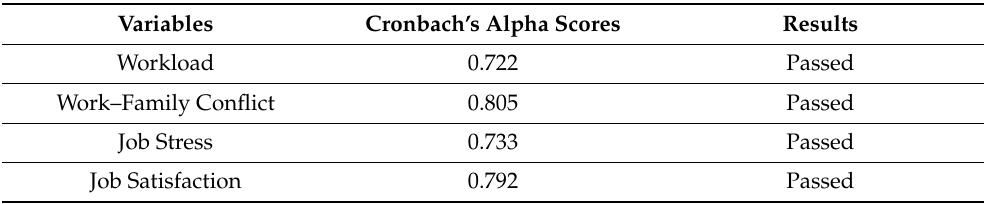
Table 2. Content reliability of pilot